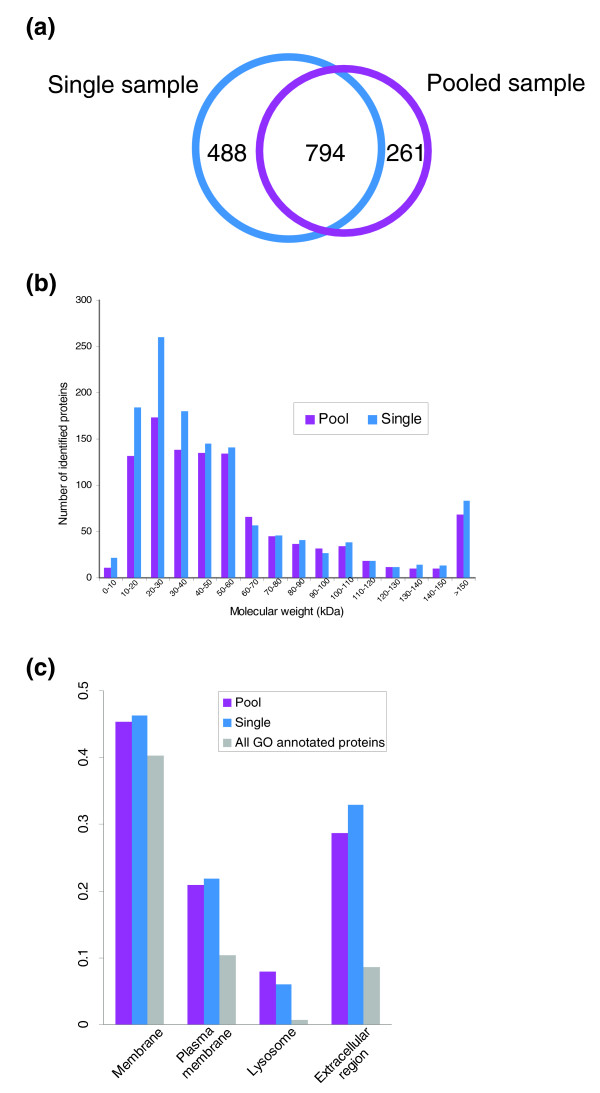
Comparison of identified proteins in urine of a single person and pooled urine from nine persons. (a) Overlapping proteins, (b) molecular weight distribution, and (c) cellular localization were compared. The ratio of membrane, plasma membrane, lysosome, and extracellular region proteins in each dataset were calculated using BiNGO, as described in the Materials and Methods section. GO, Gene Ontology.